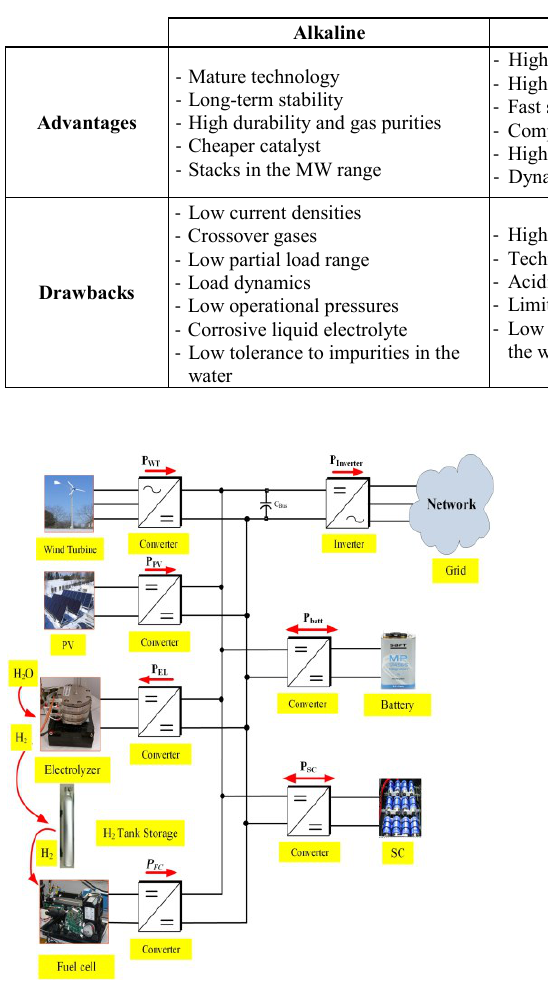
Fig. 1. Hybrid renewable energy system with a hydrogen buffer storage based on a DC bus configuration.